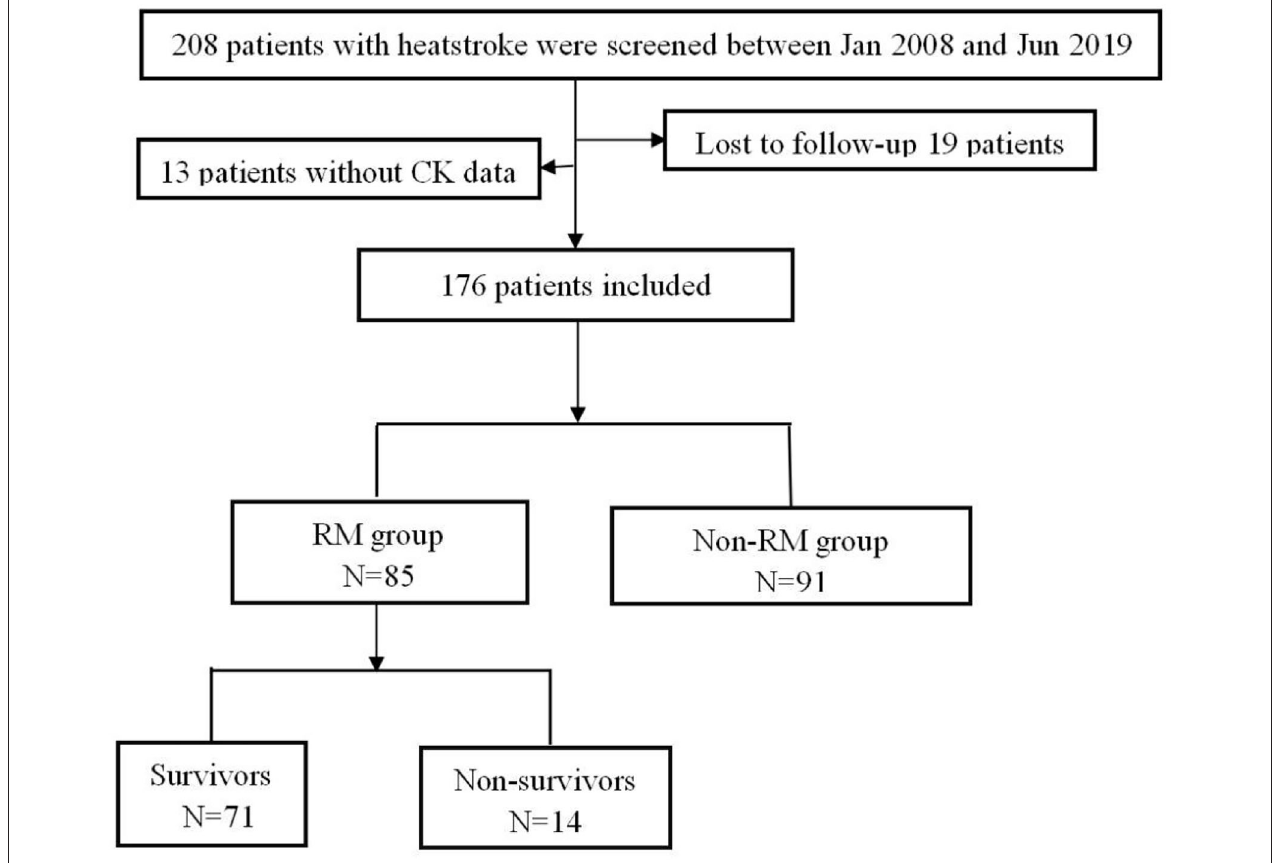
FIGURE 1 | Flowchart of all excluded and included